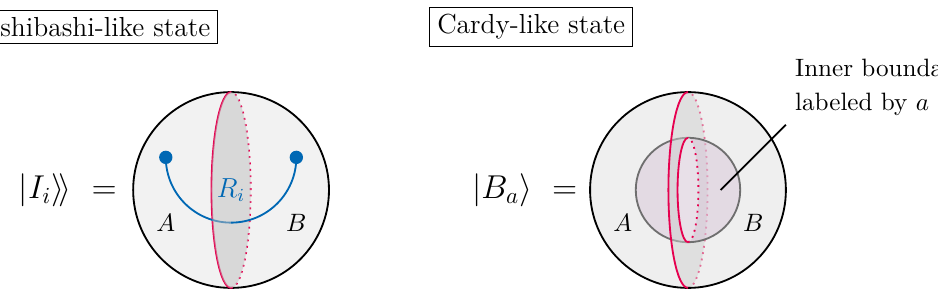
Figure 9 . Analogues of boundary states in Chern-Simons theory. The Ishibashi-like state is defined as a state on the surface ( S 2 ) of a ball where a pair of excitations is located across the common boundary of the two regions A and B [Left]. On the other hand the Cardy-like state is defined as a state on the surface of a ball with the inner boundary surface with a specific boundary condition corresponding to (2.77)